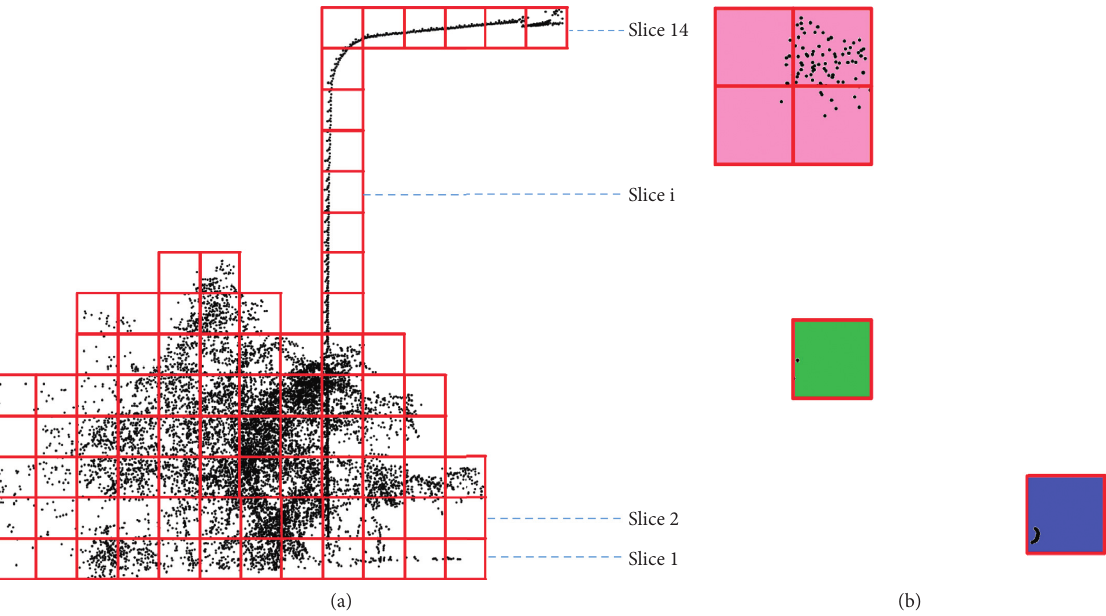
Figure 6: Selecting voxels based on horizontal cross section analysis. (a) Voxelization; (b) a set of voxel groups at slice 8, satisfying the limited number of voxel criteria (different voxel groups are shown by different